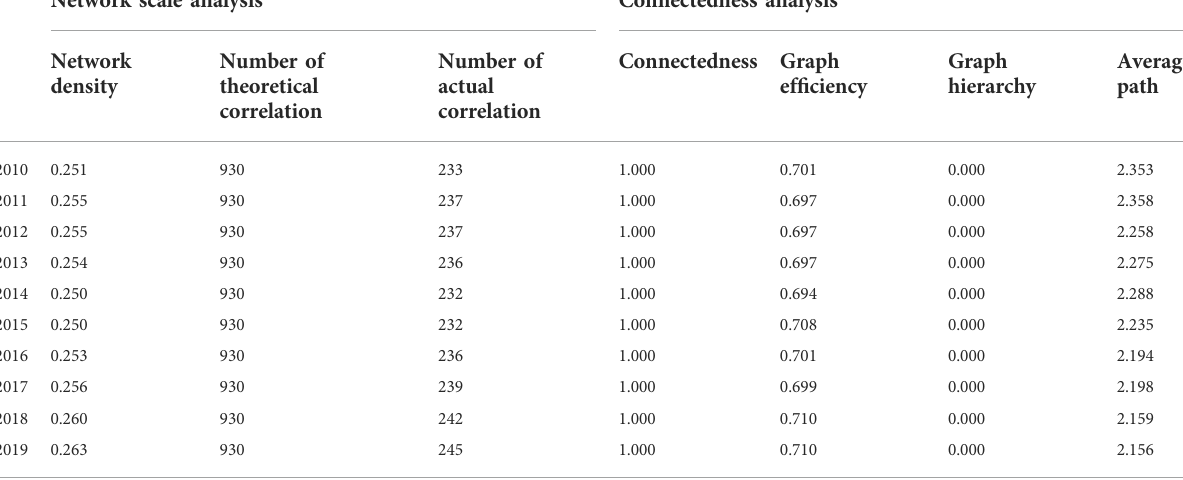
TABLE 2 Overall network characteristics of the impact of green fi nance development on industrial structure